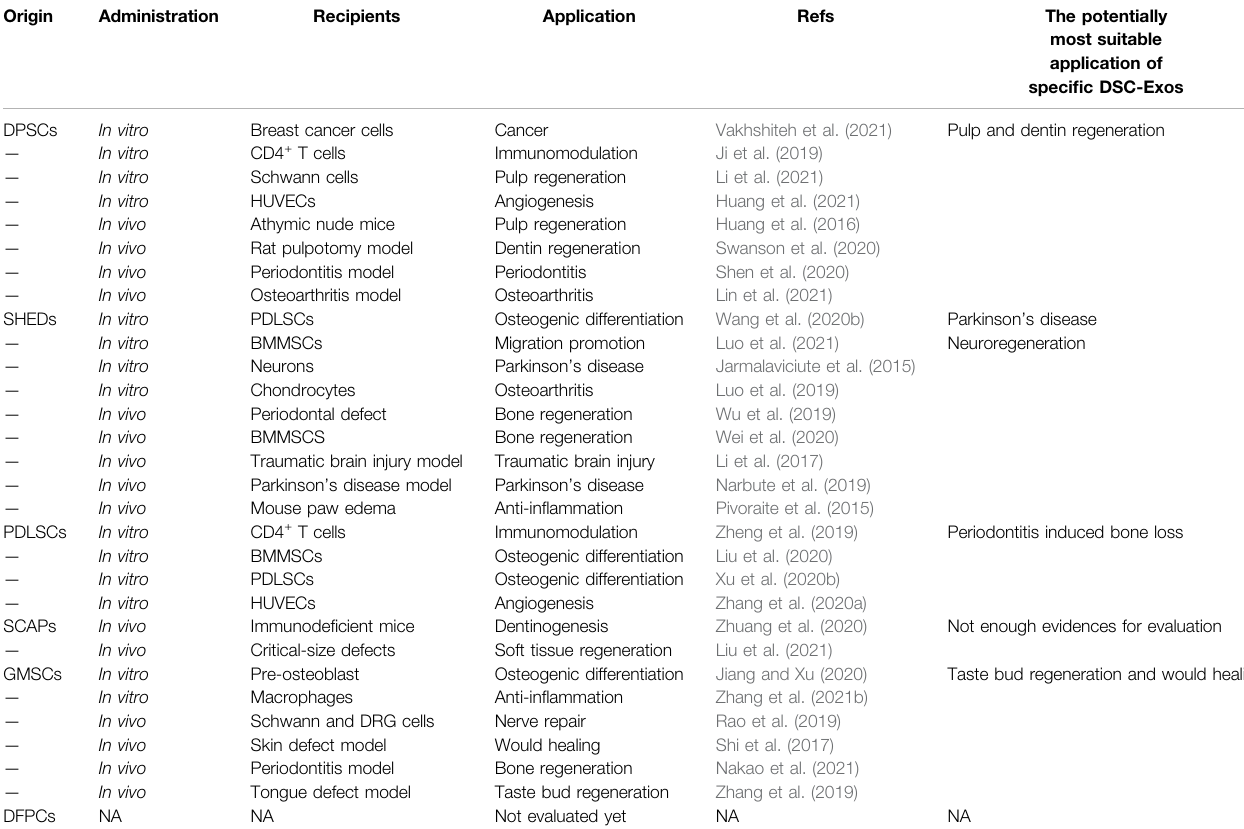
TABLE 2 | The potential clinical application of